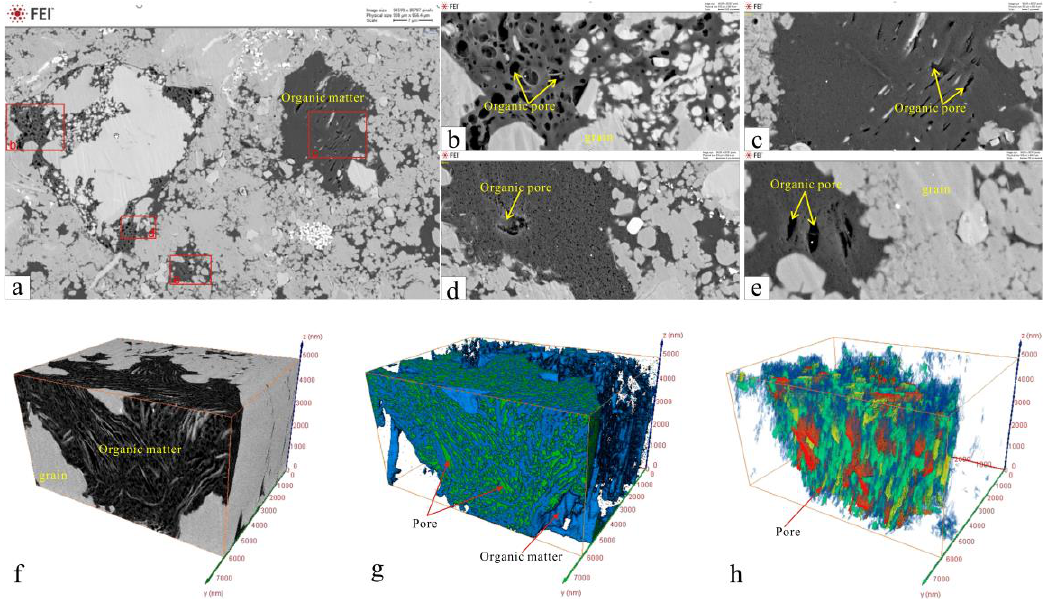
Figure 6. Comprehensive observation of organic pore characteristics. ( a – e ). SEM observation of organic pores. ( f – h ), 3D reconstructed image of nanometric scale shale core ( f ). core image, ( g ). organic matter and organic pores image, ( h ). distribution of organic pores.